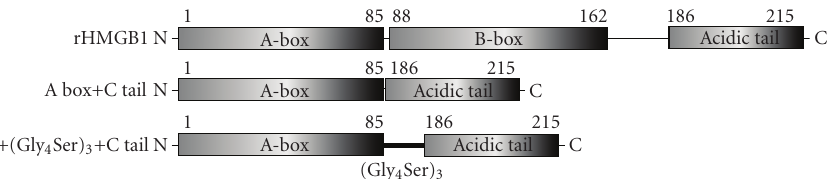
Figure 1: Schematic representation of the C tail-fused A box proteins used in this work. Wild type human HMGB1 is composed of three domains: the A box (amino acid residues 1–85), the B box (amino acid residues 88–162), and the C tail (amino acid residues 186–215). A box+C tail: A box fused with C tail directly. A box+(Gly 4 Ser) 3 +C tail: A box fused with C tail via a (Gly 4 Ser) 3 linker.